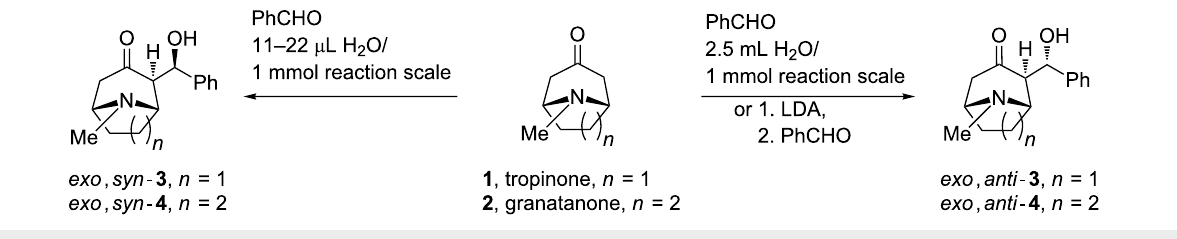
Scheme 1: Typical preparation of representative tropinone and granatanone aldols [3,17,20].